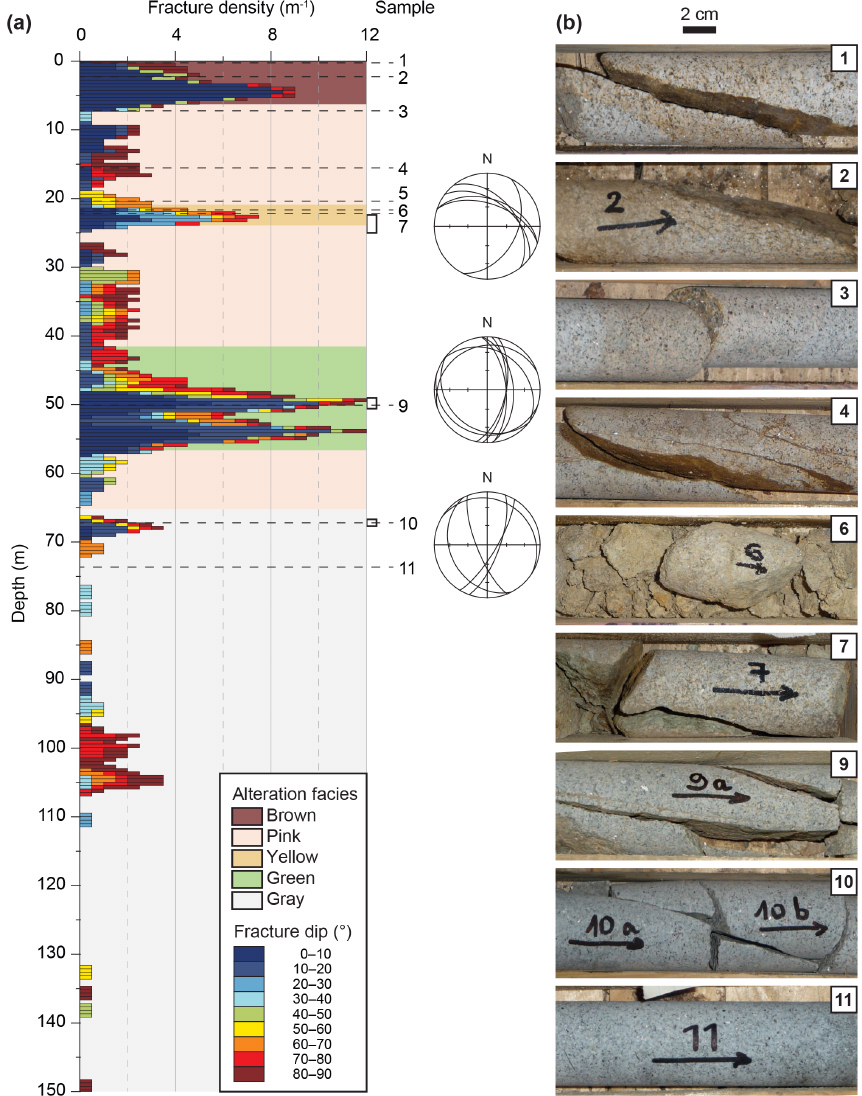
Figure 2. Fracture and alteration setting of samples. (a) Borehole log showing fracture density distribution (modified after Lexa and Schul- mann, 2006), macroscopic alteration zones and position of samples. The pole diagrams (Schmidt projection) show orientation of fractures in the vicinity of samples with the depth range defined by the rectangles at the right side of the log (based on the acoustic borehole image, not available for the uppermost 22.5m); (b) photographs of the